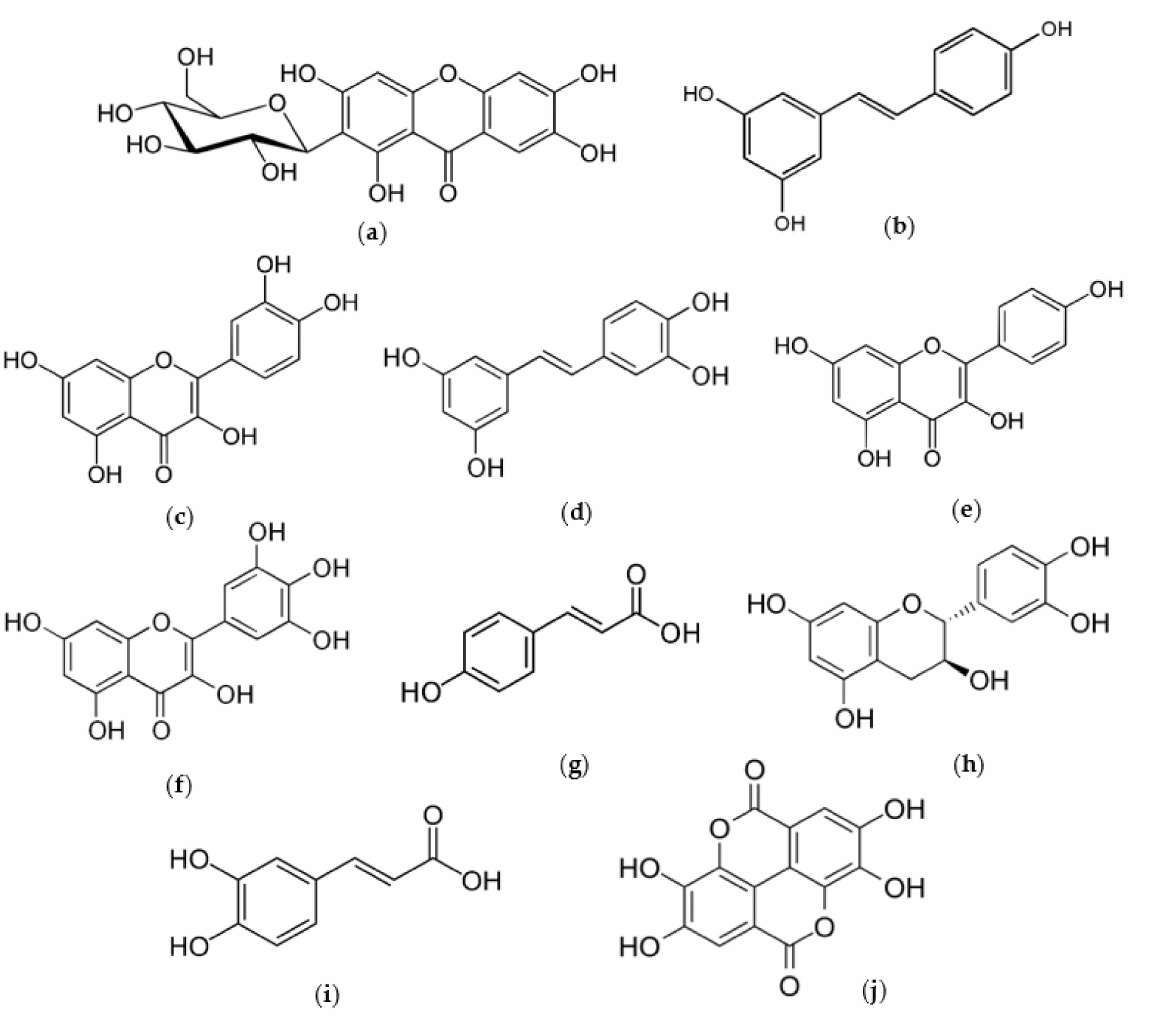
Figure 2. Some highlighted phenolic compounds: mangiferin ( a ), resveratrol ( b ), quercetin ( c ), piceatannol ( d ), kaempferol ( e ), myricetin ( f ), p-coumaric acid ( g ), catequin ( h ), caffeic acid ( i ) and ellagic acid ( j